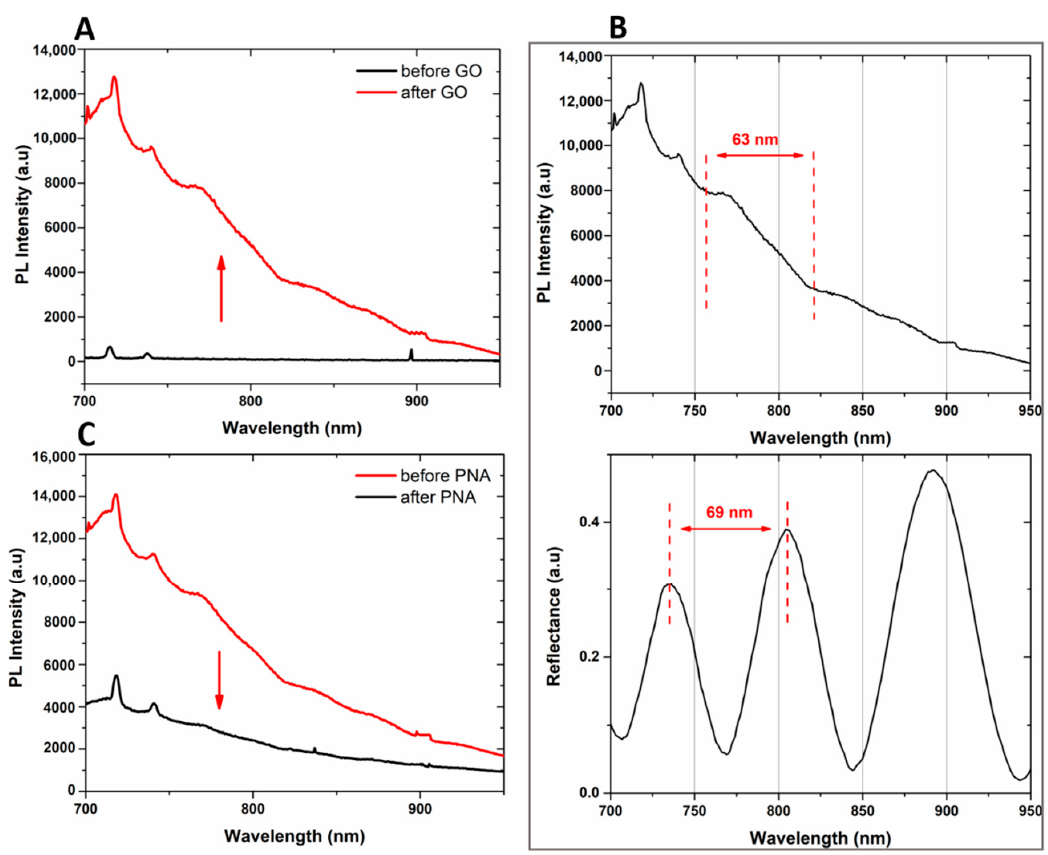
Figure 5. ( A ) photoluminescence spectra of PSi before (black line) and after (red line) GO infiltration at an excitation wavelength of 442 nm. ( B ) Comparison between PL spectrum (upper graph) and reflectivity spectrum (lower graph) of GO / PSi hybrid device. ( C ) PL spectra of PSi before (red line) and after (black line) PNA immobilization, at an excitation wavelength of 442 nm. The PNA-GO/PSi device was then incubated with complementary (DNA) and non-